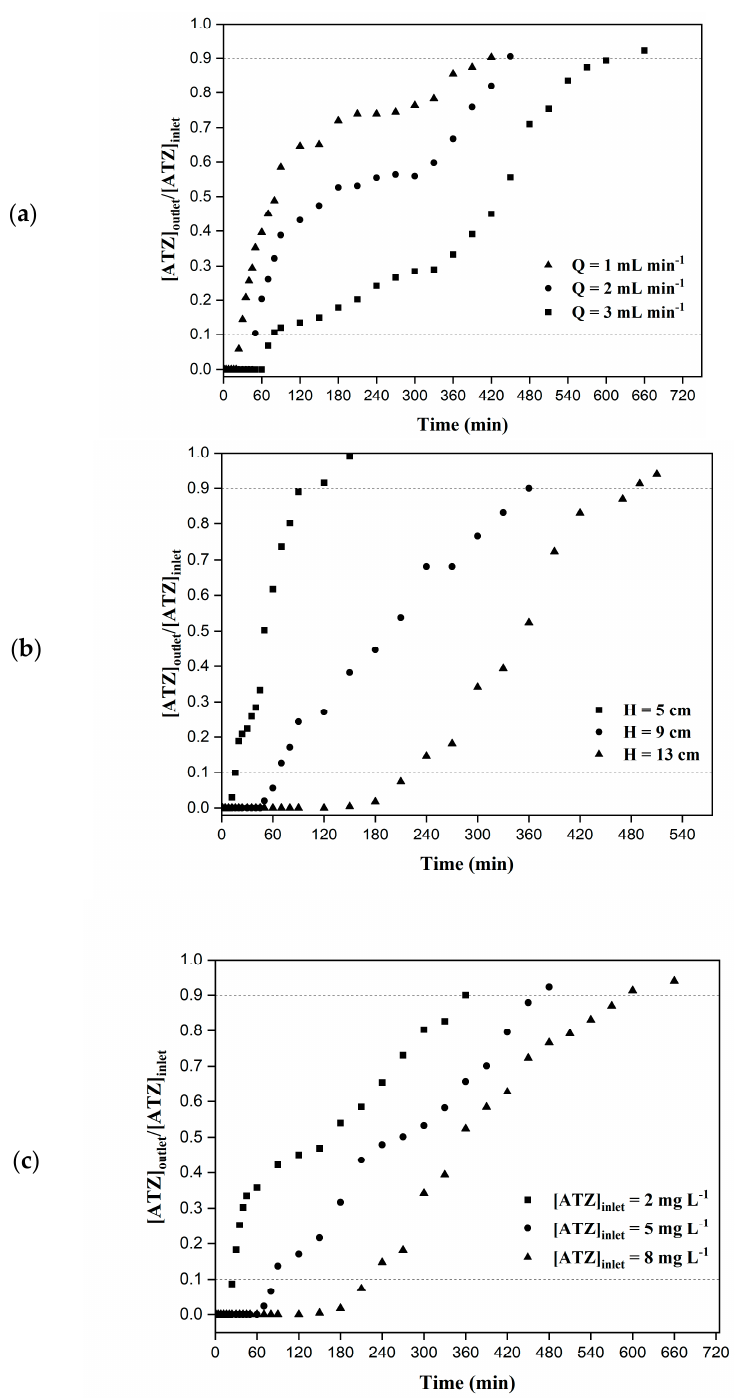
Figure 6. Breakthrough curves for the ATZ adsorption in a packed-bed column using Moringa oleifera Lam. seeds as adsorbent: ( a ) effect of peristaltic pump flow rate with solution pH 5.0, fixed bed height (13 cm), and [ATZ] inlet = 2 mg L − 1 at T = 25 °C; ( b ) effect of the bed height with [ATZ] inlet = 2 mg L − 1 , flow rate of 1 mL min − 1 , and pH 5.0; ( c ) effect of the inlet ATZ concentration with flow rate fixed at 1 mL min − 1 , pH 5.0, and bed height of 13 cm.